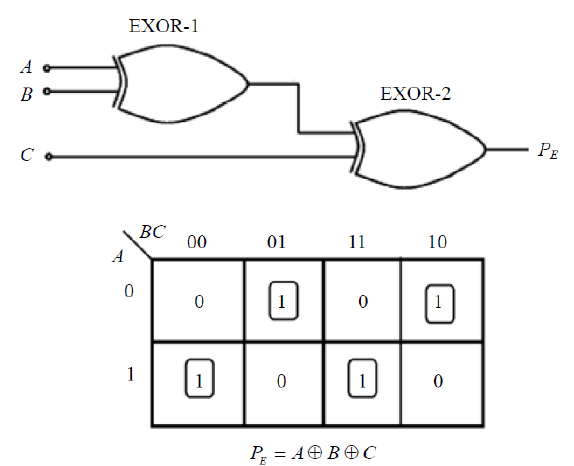
Fig. 3 Digital circuit and K-map of three bit even parity generator